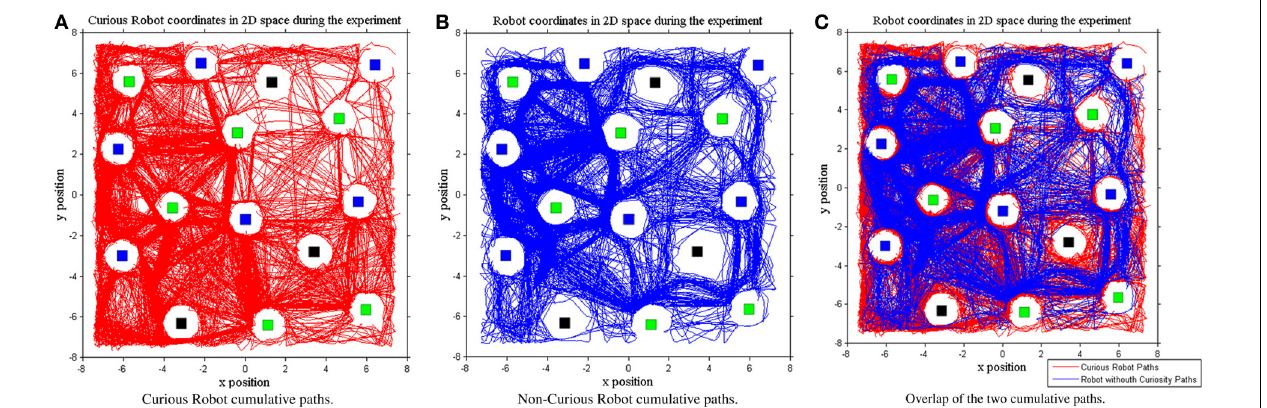
FIGURE 11 | Space of the environment explored during the Curious (A—red line) or Non-Curious (B—blue line) Learning Systems execution. The third graph represents the comparison between the two systems (C)